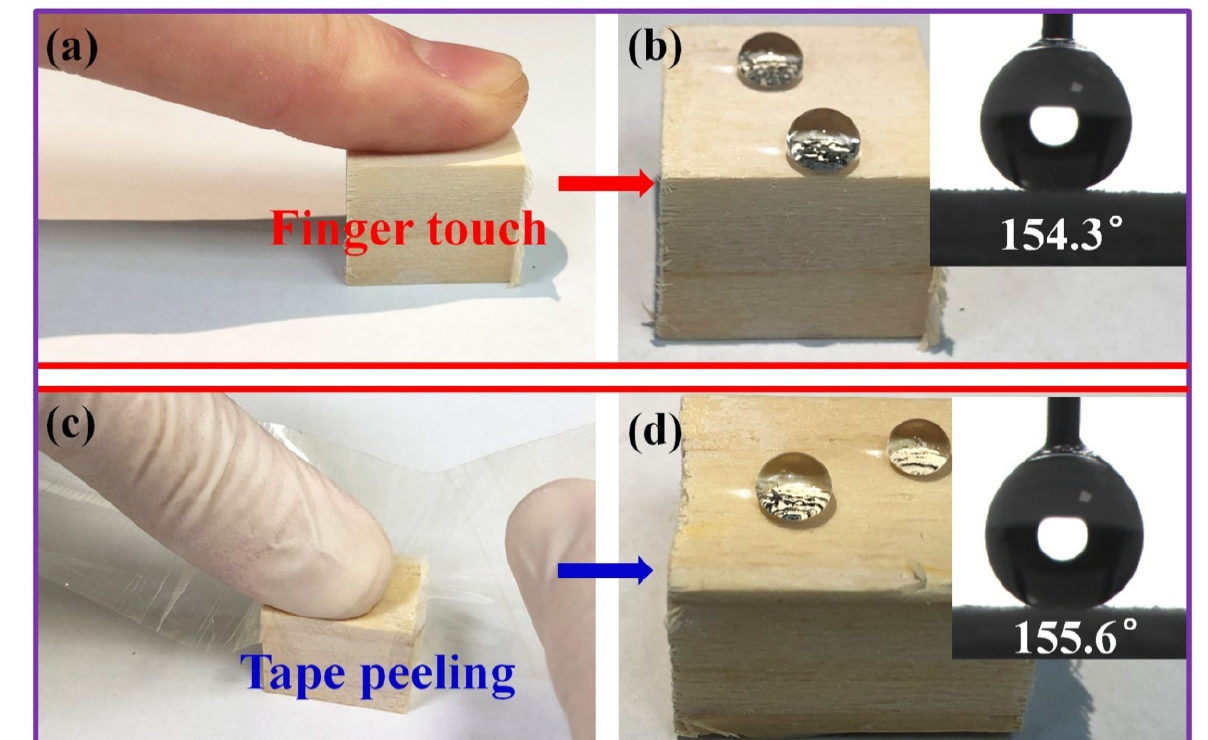
Figure 7. Finger touching ( a , b ) and tape peeling ( c , d ) tests on superhydrophobic silicone resin coating surface.